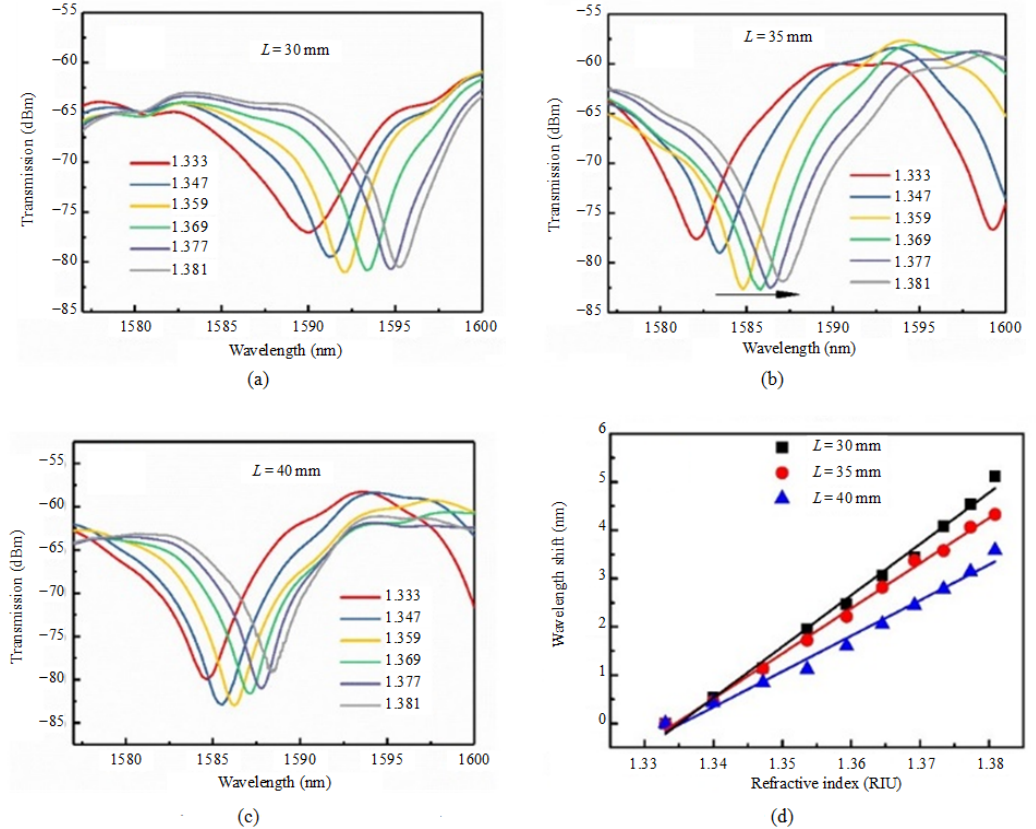
Fig. 4 Spectral change diagram of three different lengths PCF interferometers in different refractive index liquids (a) L =30 mm, (b) L =35 mm, (c) L =40 mm, and (d) relationship between the wavelength shift and surrounding RI of the PCF interferometer with different etching